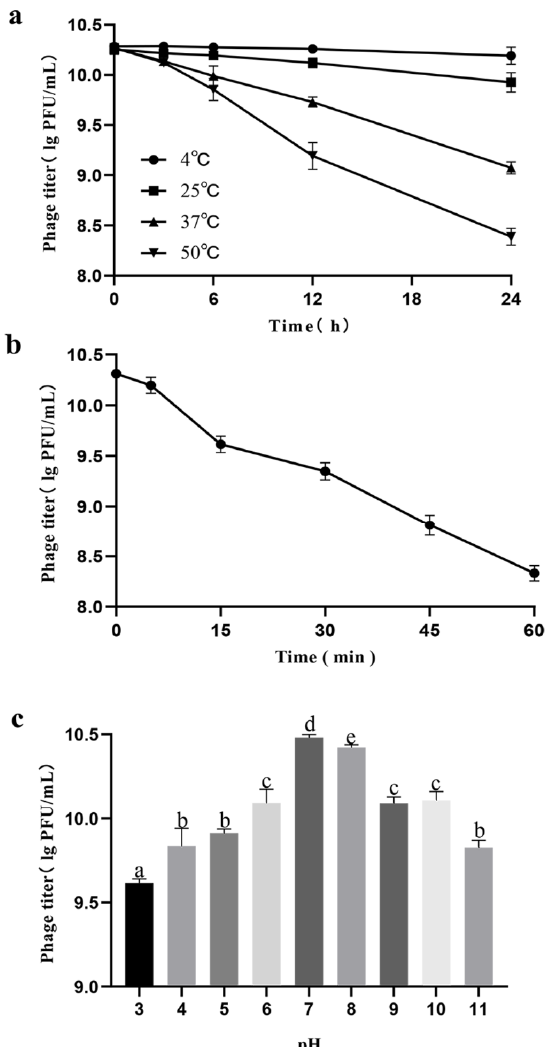
Figure 3. Stability of phage PHB09 in different conditions. ( a ) Stability at different temperature. ( b ) Stability to exposure of ultraviolet light. ( c ) Stability to changes in pH value. Values are means from three independent experiments. Means with the same letter are not significantly different from each other. Error bars indicate standard deviation.